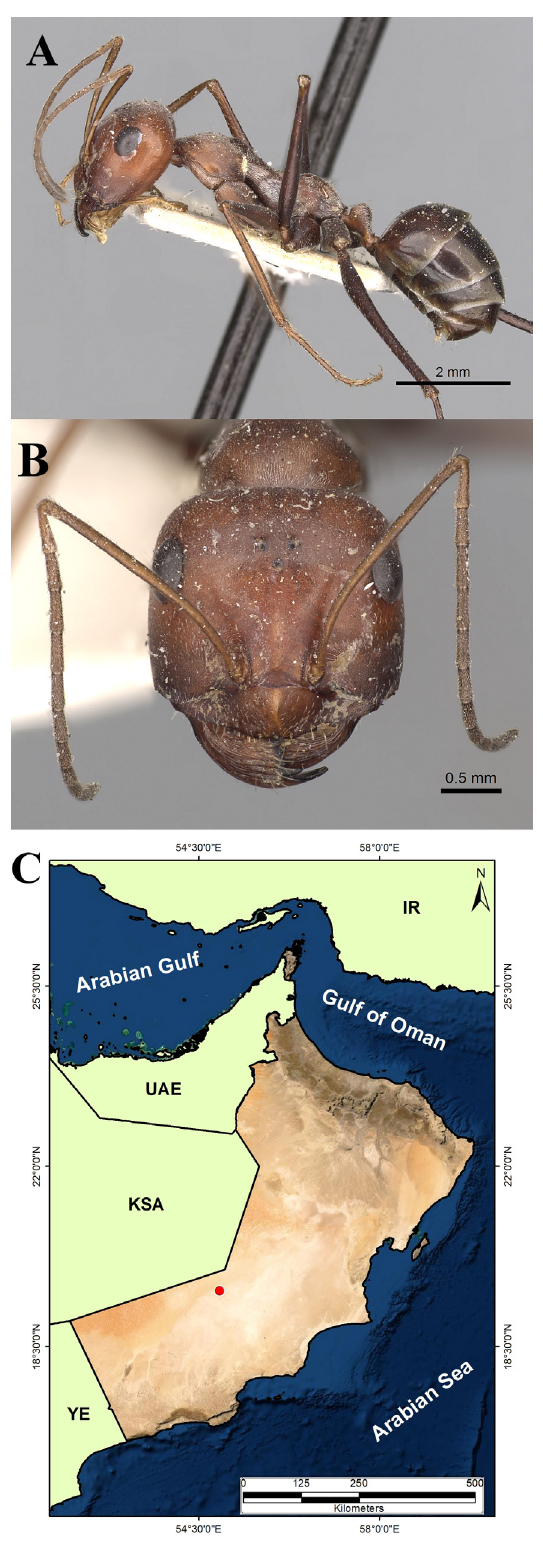
Fig. 9. Cataglyphis adenensis (Forel 1904), syntype, worker (CASENT0249890, AntWeb.org (Shannon Hartman)). A . Body in profile. B . Head in full-face view. C . Distribution